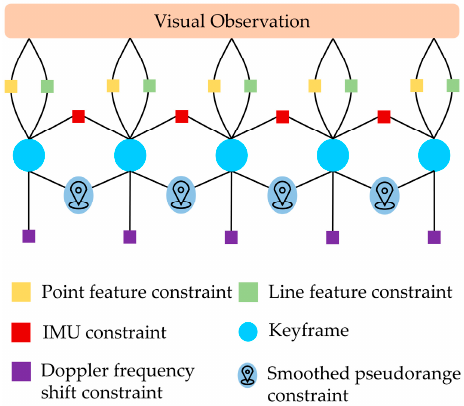
Figure 3. Factor graph illustration of our system.